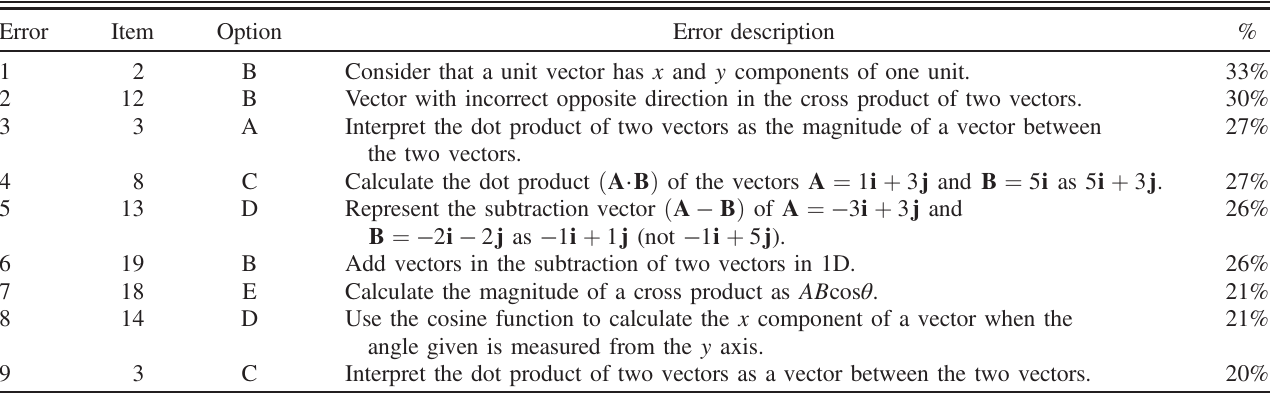
TABLE VII. Incorrect answers on the TUV with frequency rates of equal to or greater than 20%. (Answers are in order of decreasing percentage.) Error Item Option Error description % Consider that a unit vector has x and y components of one unit. Vector with incorrect opposite direction in the cross product of two vectors. Interpret the dot product of two vectors as the magnitude of a vector between the two vectors. D Represent the subtraction vector ð A − B Þ of A ¼ − 3 i þ 3 j and